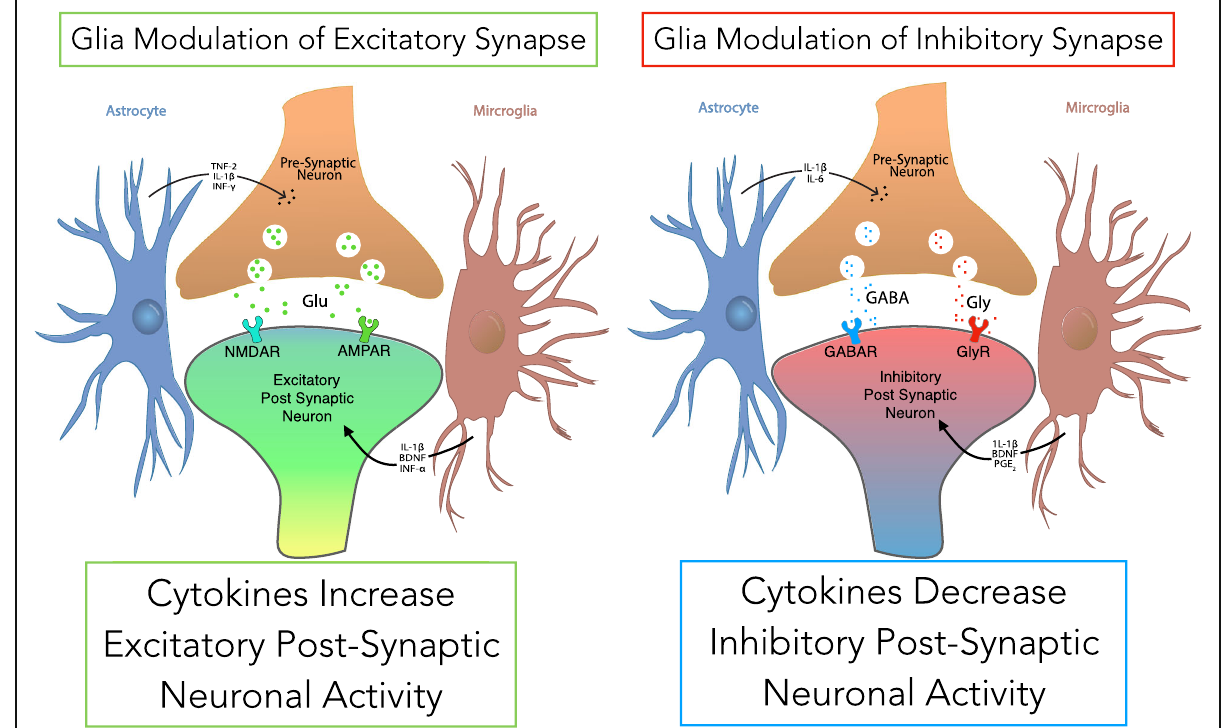
Fig. 6 Local Glia Modulate Synaptic Transmission After Nerve Injury. Glia are intimately associated with spinal excitatory and inhibitory synapses. The release of cytokines and glial mediators on pre and post-synaptic terminals modulates the activity of that synapse. Cytokines released at glutaminergic excitatory synapses augment transmission while cytokines released at GABAergic and Glycinergic synapses attenuates the signal. The net effect of gliosis and release of glial mediators is an increase in spinal cord pain transmission. Novel modes of SCS may modulate glial activity, thereby enacting their antinociceptive mechanisms through this pathway. Acronyms: Glu (Glutamate), GABA (Gamma Aminobutyric Acid), Gly (Glycine), TNF- α (Tumor Necrosis Factor Alpha), IL-1 β (Interleukin 1 β ), IFN- γ (Interferon Gamma), NMDAR (NMDA Receptor), AMPAR (AMPA Receptor), BDNF (Brain Derived Neurotrophic Factor), GABAR (GABA Receptor), GlyR (Glycine Receptor), PGE 2 (Prostaglandin E 2